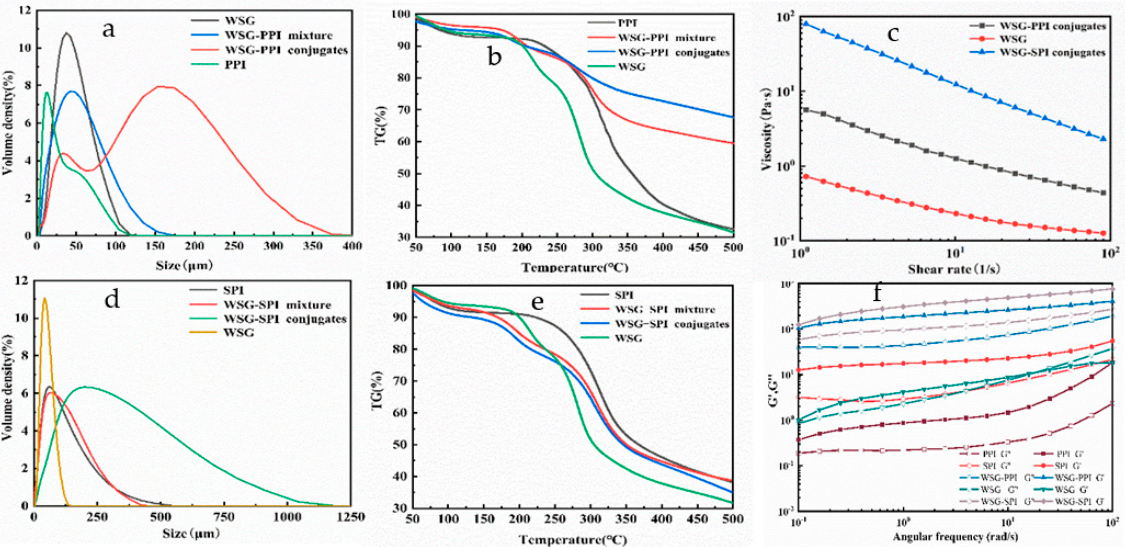
Figure 3. Functional properties of WSG and its conjugates: ( a ) particle size of WSG-PPI conjugates; ( b ) TGA of WSG-PPI conjugates; ( c ) rheological properties of WSG-PPI conjugates; ( d ) particle size of WSG-SPI conjugates; ( e ) TGA of WSG-SPI conjugates; ( f ) rheological of WSG-SPI conjugates.